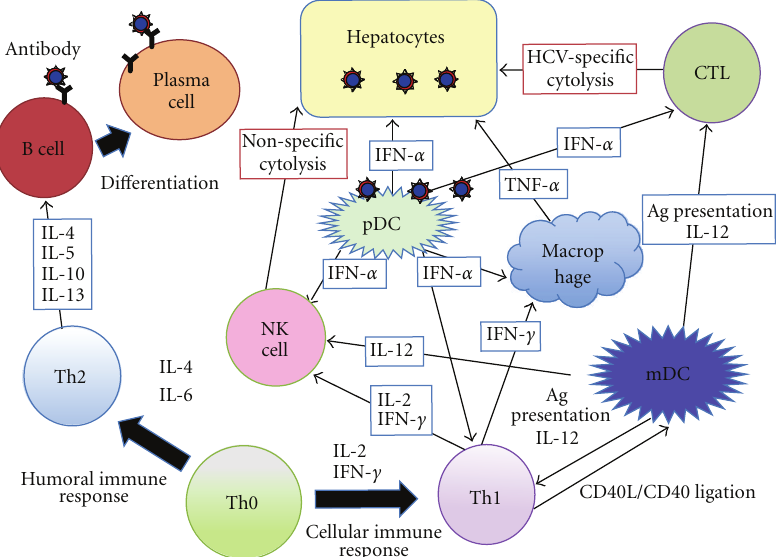
Figure 1: Cellular and humoral immune responses in HCV infection. Plasmacytoid dendritic cells (pDC) recognize HCV infection and produce IFN- α , which activates natural killer (NK) cells, helper T (Th) cells, macrophages, and cytotoxic T lymphocytes (CTLs). Activated NK cells destroy the HCV-infected hepatocytes in a nonspecific manner, whereas CTLs destroy the infected hepatocytes in an antigen-specific manner. Myeloid dendritic cells (mDC), which recognize dead hepatocytes, secrete IL-12, promoting the activation of NK cells, Th1 cells, and CTLs. Activated Th1 cells, in turn, promote DC maturation by interacting with the CD40/CD40 ligand. Macrophages stimulated by type 1 helper T (Th1) cells produce TNF- α , which accelerates local inflammation. In humoral immune responses, Th2 cells activate B cells. Plasma cells di ff erentiated from B-cells secrete immunoglobulins to neutralize the circulating HCV. Abbreviated terms: CTL, cytotoxic T lymphocyte; pDC, plasmacytoid dendritic cells; mDC, myeloid dendritic cells; Th1 cell, type 1 helper T cell; Th2 cell, type 2 helper T cell; NK cell, natural killer cell; IFN, interferon; IL, interleukin; TNF, tumor necrosis